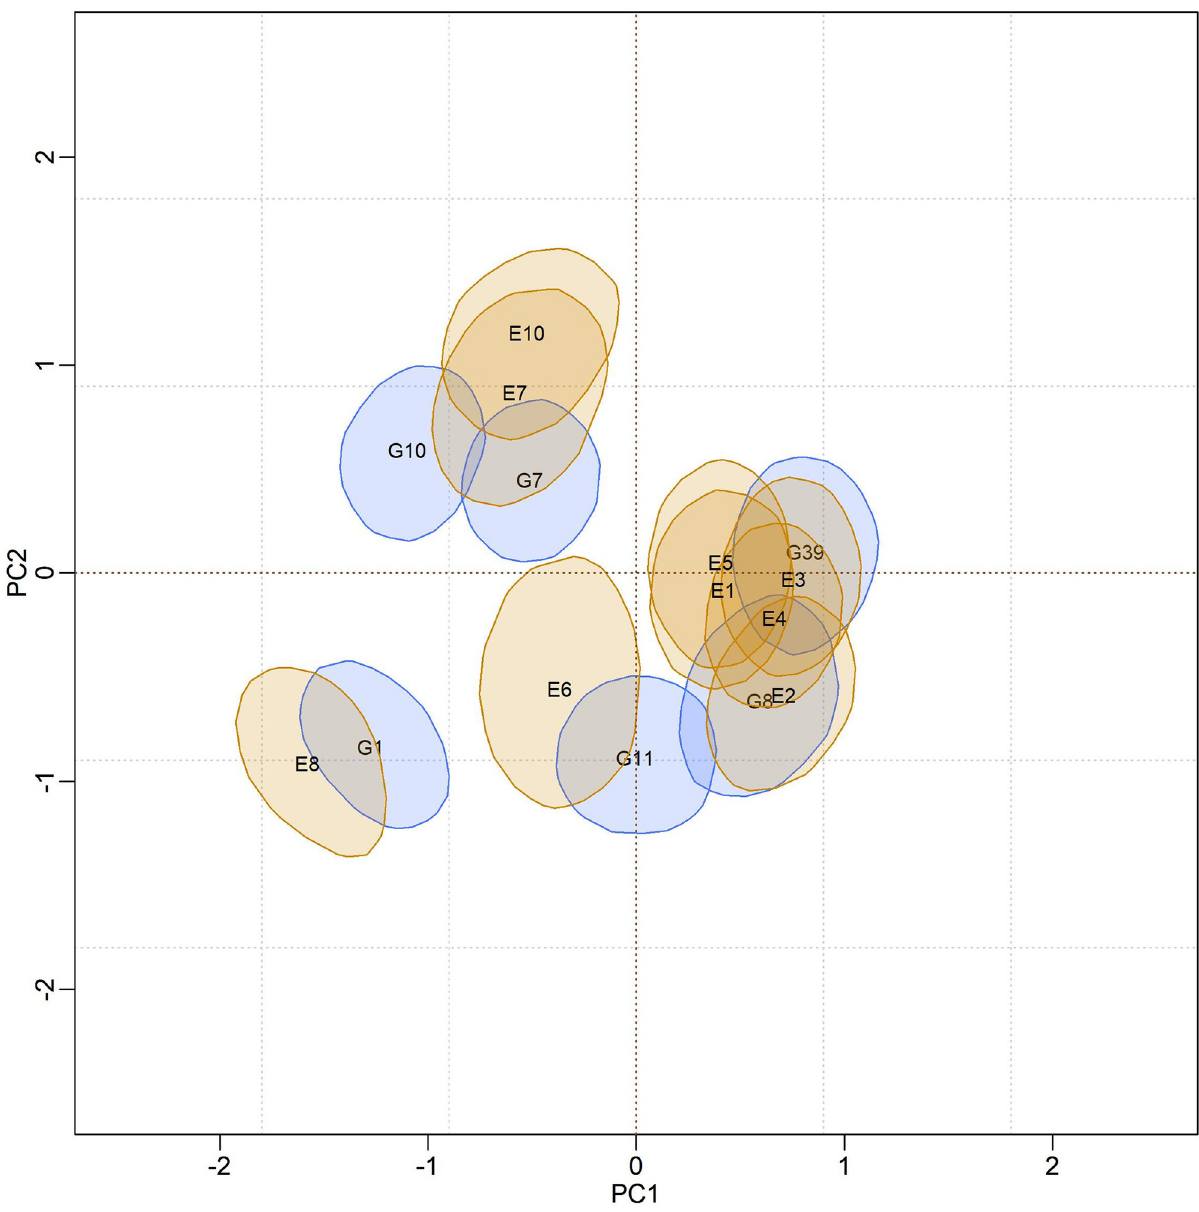
Fig 21. Bivariate credibility regions at 95% probability for the genotypic and environmental scores of the BAMMI-4 model for real data, adjusted using the MCMC method. Only regions whose regions do not contain the origin (0.0) were